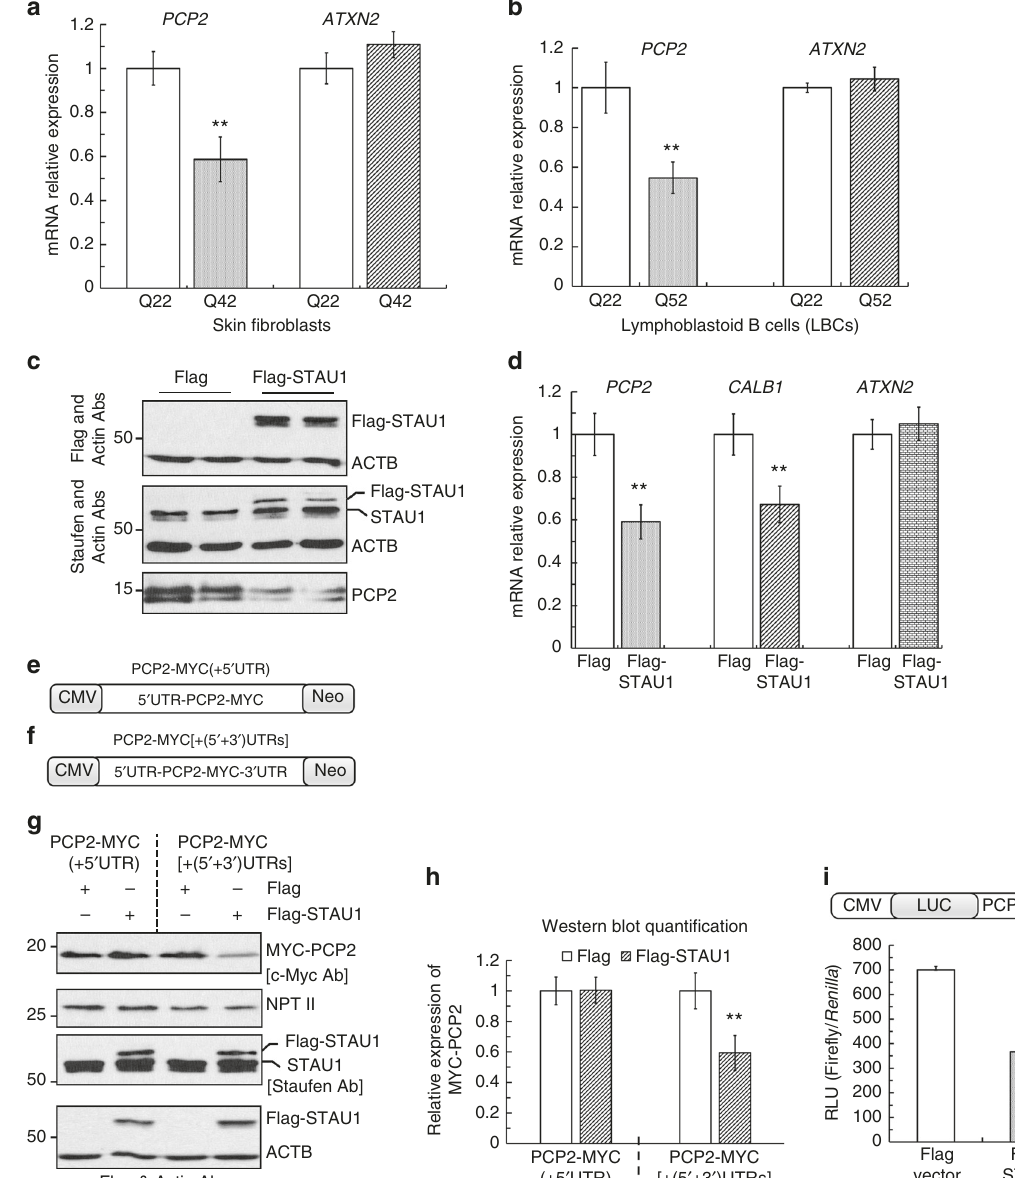
Fig. 4 Elevated STAU1 levels induce aberrant processing of RNA targets. a , b In qRT-PCR analyses, SCA2- FBs ( a ) or LBCs ( b ) revealed signi fi cantly reduced PCP2 mRNA abundance compared to normal controls; ATXN2 mRNA levels are not changed. c , d Exogenous STAU1 reduces levels of PCP2 and CALB1 mRNAs , two mRNAs greatly reduced in SCA2 mouse models 8, 9 . c HEK-293 cells overexpressing Flag-tagged STAU1 were analyzed 48 h post- transfection by western blotting and had reduced PCP2 levels compared to controls. d Matching cultures were analyzed by qRT-PCR demonstrating decreased mRNAs for PCP2 and CALB1 but not ATXN2 compared with controls. Gene expression levels were normalized to GAPDH . e – i Increased STAU1 expression results in reduced PCP2 protein levels in a manner requiring the PCP2 -3 ′ UTR. Schematics of MYC-tagged PCP2 cDNA constructs without ( e ) or with ( f ) the 3 ′ UTR. g PCP2 constructs ( e , f ) were transfected into short-term hygromycin selected HEK-293 cells expressing Flag-STAU1. Forty-eight hours post-transfection, western blotting of cellular extracts showed signi fi cantly reduced PCP2 levels only from the constructs retaining the 3 ′ UTR ( f ). Transfection equalities were monitored by anti-neomycin phosphotransferase (NPTII), expressed independently by the PCP2 plasmids. h Quanti fi cation of MYC-tagged PCP2 expression on western blots. β -Actin was used as loading control and representative blots of three independent experiments are shown. i In the presence of exogenous STAU1, the 3 ′ UTR is required to reduce luciferase expression. Luciferase expression was reported relative to Renilla luciferase (RLU). Data are mean ± SD, ** P < 0.01, *** P < 0.001, Student t To test whether depleting mutant ATXN2 in SCA2 cells had an parallel, depletion of ATXN2 by RNAi also resulted in normal- effect on STAU1 abundance, we depleted mutant ATXN2 dose- ization of STAU1 levels in ATXN2-Q22/58 KI cells compared to wise in SCA2- LBCs (ATXN2-Q22/52) or FBs (ATXN2-Q22/42) control RNAi (Supplementary Fig. 4b). Notably, reducing by ATXN2 RNAi. Reducing ATXN2 levels demonstrated ATXN2 levels did not affect Staufen1 protein and transcript signi fi cant reduction of STAU1 and a signi fi cant increase of levels in control HEK-293 cells, and in cerebella from Atxn2 PCP2 mRNA levels compared to control RNAi (Fig. 6d – i). In knock-out mice 49 (8 weeks of age) (Supplementary Fig. 4b, c).